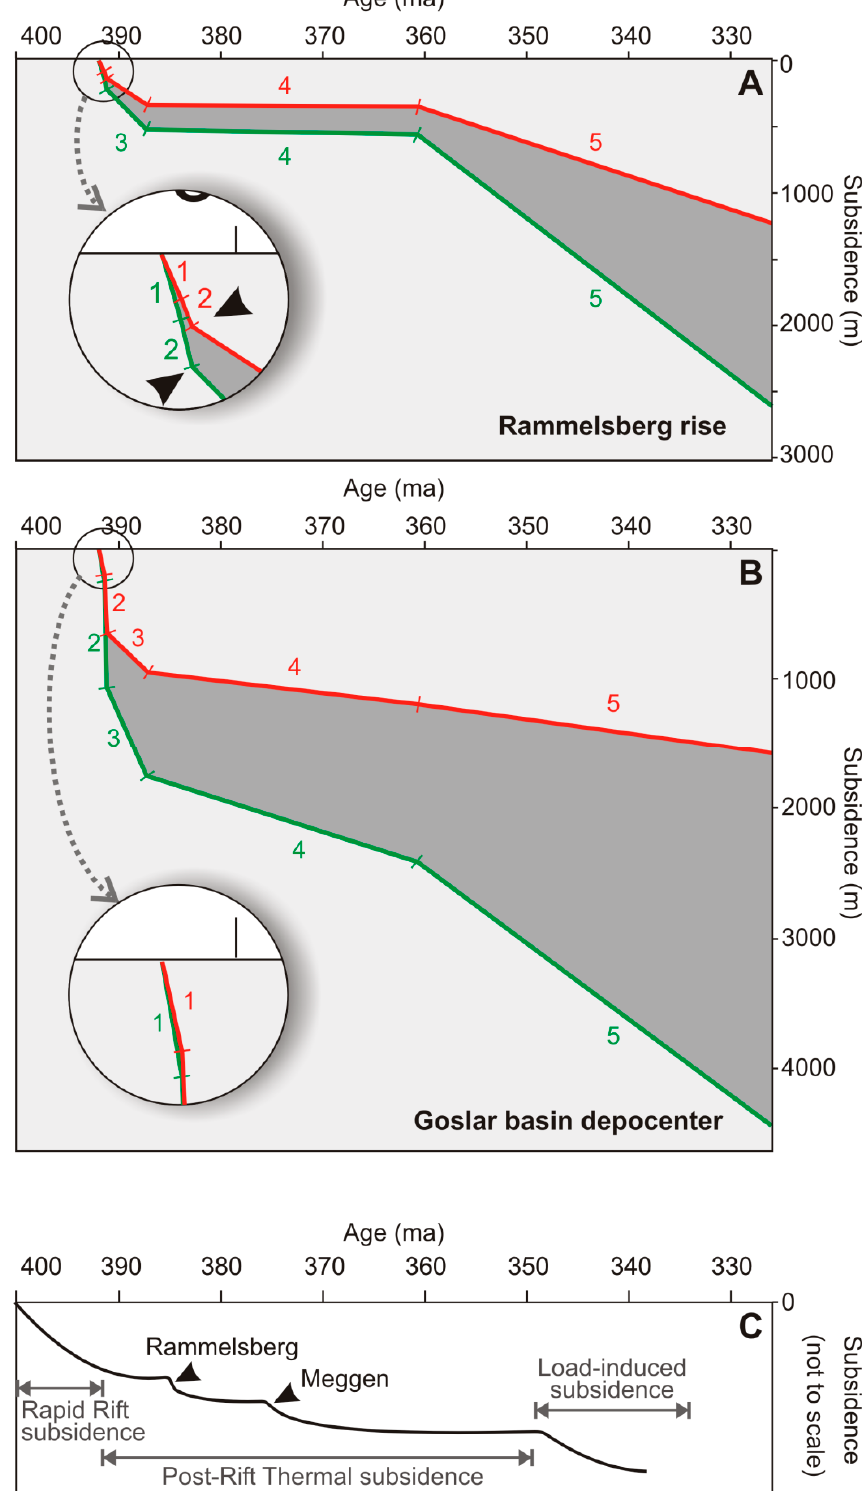
Figure 4. Total accommodation (green) and tectonic subsidence (red) curves for the Rammelsberg rise ( A ) and Goslar basin depocenter ( B ) indicating the five stages considered in this study; Black arrows show the location of the ore horizon; ( C ) Generalized subsidence curve (with no specification of the subsidence type, location and thickness) for the Rhenish Massif, after Large [3].